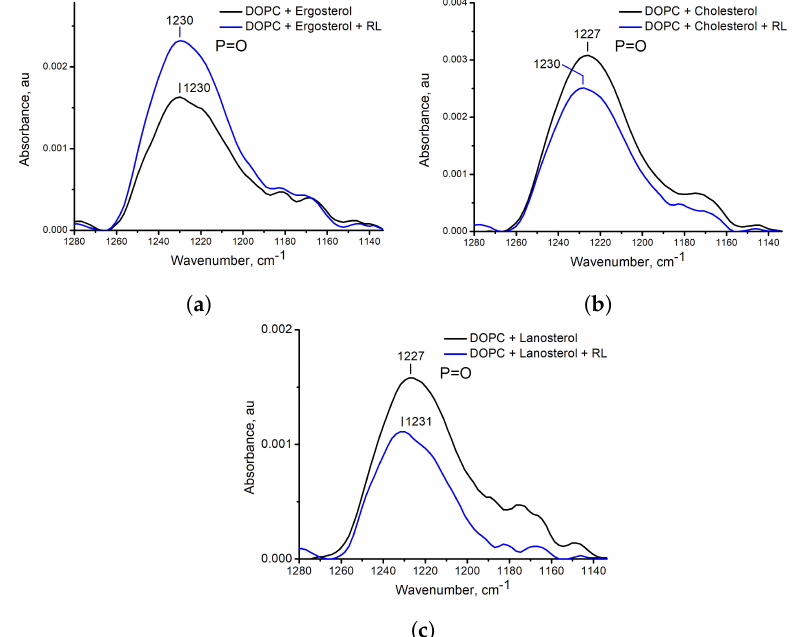
Figure 9. ATR − FTIR spectra in the region of P=O vibration for DOPC liposomes with ergosterol ( a ), cholesterol ( b ), and lanosterol ( c ) without rhamnolipids (black solid line) and with aqueous injection of rhamnolipids (blue solid